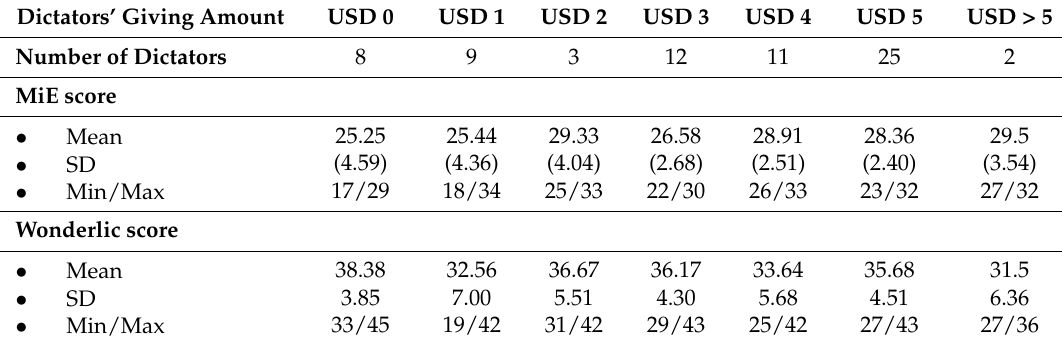
Table 2. Dictators’ giving and MiE